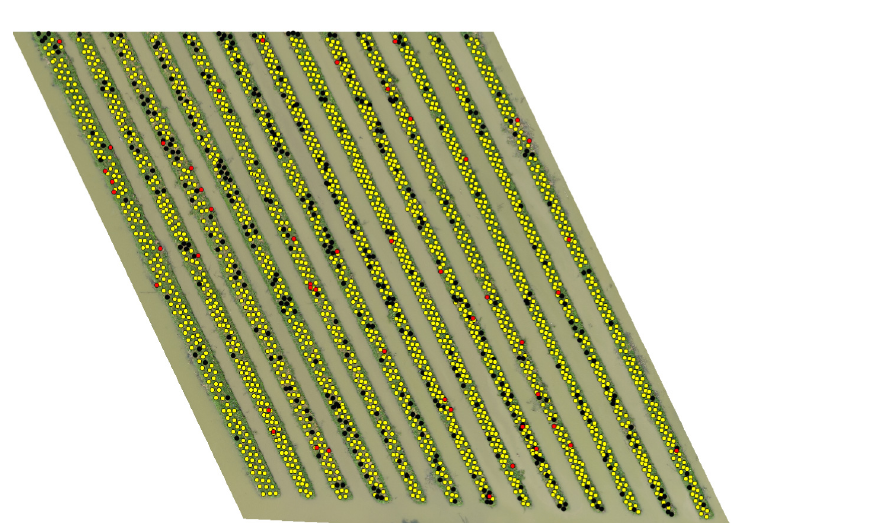
Fig 9. Final detection on ROI of 50m altitude